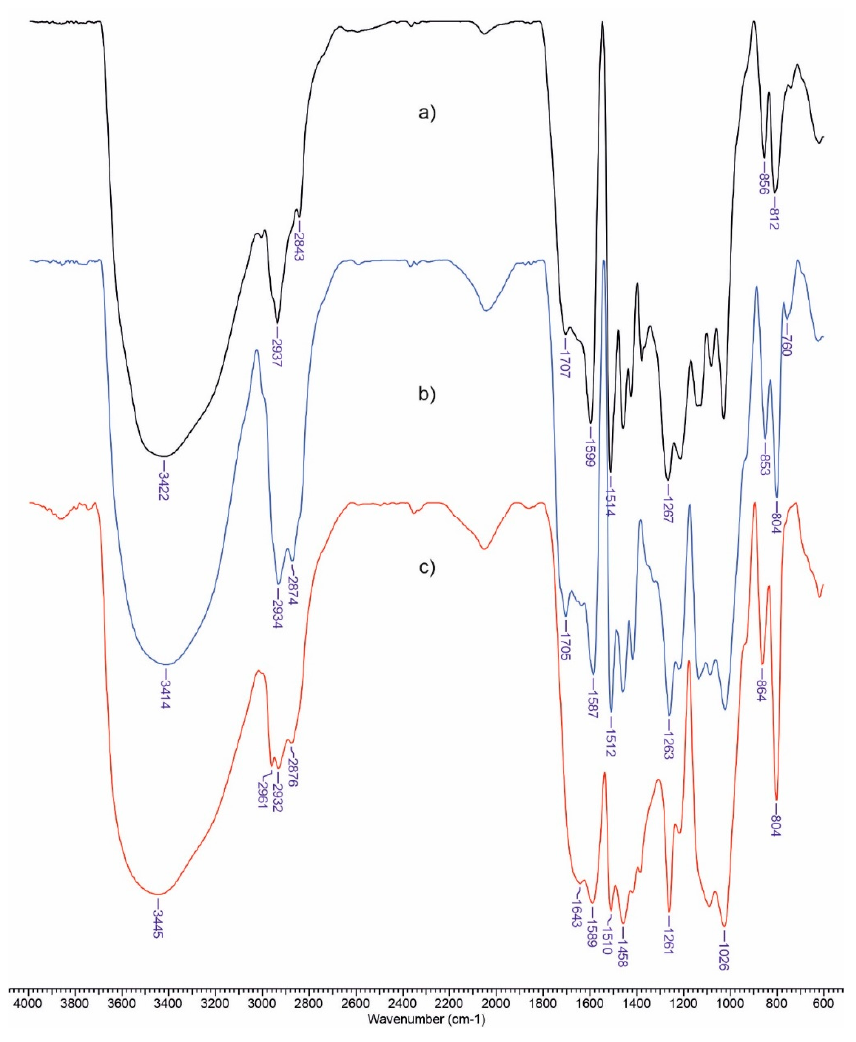
Figure 1. FTIR spectra of LIG ( a ), Lep ( b ), and LCD ( c ). Table 1. Condensation index for the base